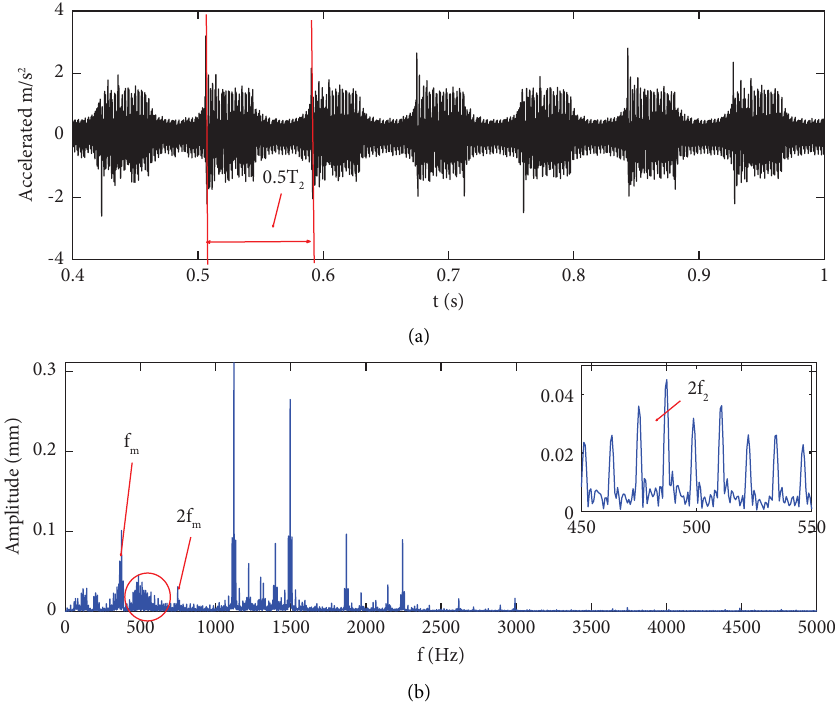
Figure 18: Te responses of the wheel node of the driven shaft with polygon fault: (a) the time domain; (b) the frequency domain.